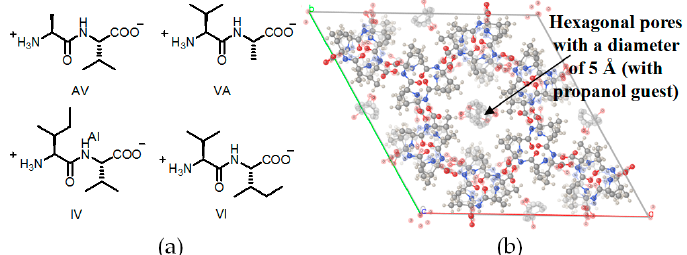
Figure 16. ( a ) Structure of building motifs of 15a (AV: L-Ala–L-Val), 15b (VA: L-Val–L-Ala), 15c (IV: L-Iso–L-Val), and 15d (VI: L-Val–L-Iso); ( b ) The hexagonal shaped pore in crystalline H15a (crystal grown from 2-propanol) [55].